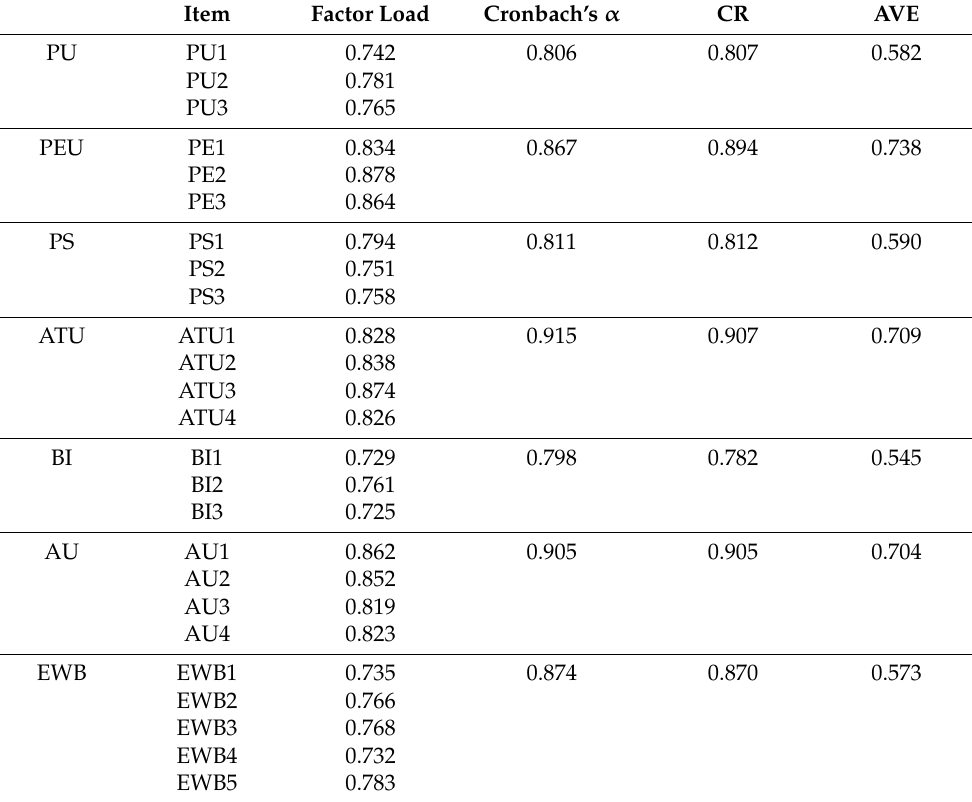
Table 2. Reliability and validity of the measurement model in this research.